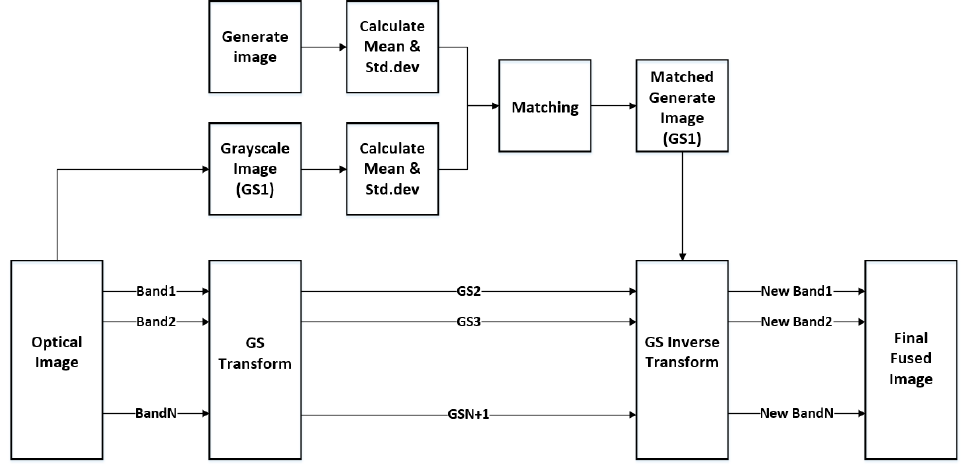
Figure 1. Gram–Schmidt transformation flowchart.